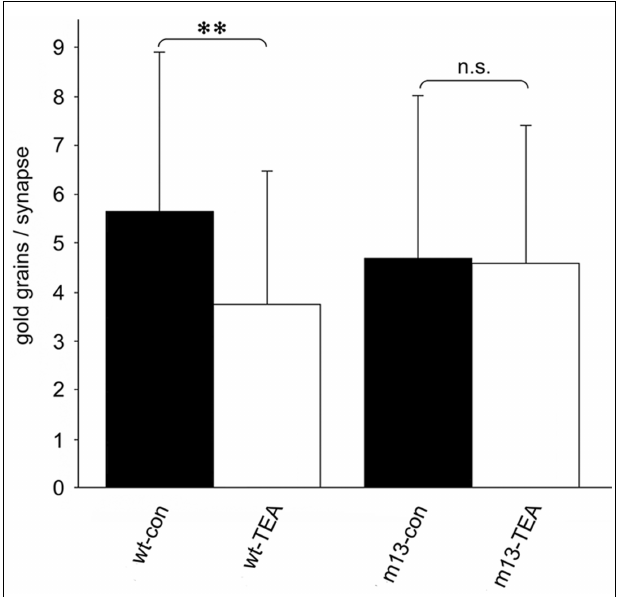
FIGURE 4 | Quantitative estimation of the number of gold grains per active zone at mossy fiber synapses in stratum lucidum of CA3 in hippocampal slice cultures subjected to HPF, freeze substitution, embedding in Lowicryl HM20 (no osmication), thin-sectioning, and immunogold labeling for p-cofilin. The number of gold grains at mossy fiber synapses is significantly higher in wild-type control cultures (wt-con) compared to wt cultures treated withTEA (wt-TEA; mean ± SD; ** p < 0.01).This difference between control tissue andTEA-treated tissue was not observed in cultures from Munc13-1 mutants (m13-con and m13-TEA, respectively). n.s., not significant. All gold grains within 100 nm of the postsynaptic density were regarded as specific labeling and were counted (60 active zones per experimental group; two-sided Student’s t -test; α = 0.05). See Studer etal. (2014) for details on the